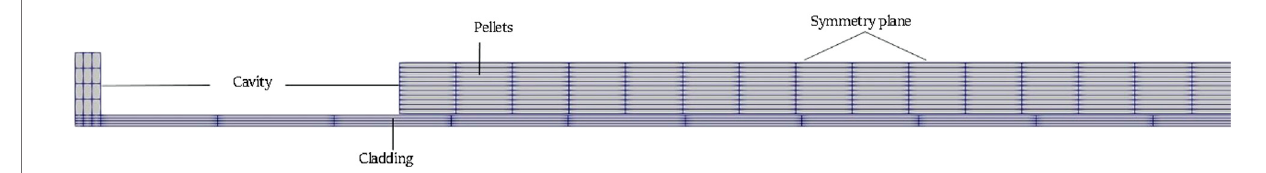
FIGURE 4 | Two-dimensional axisymmetric model.